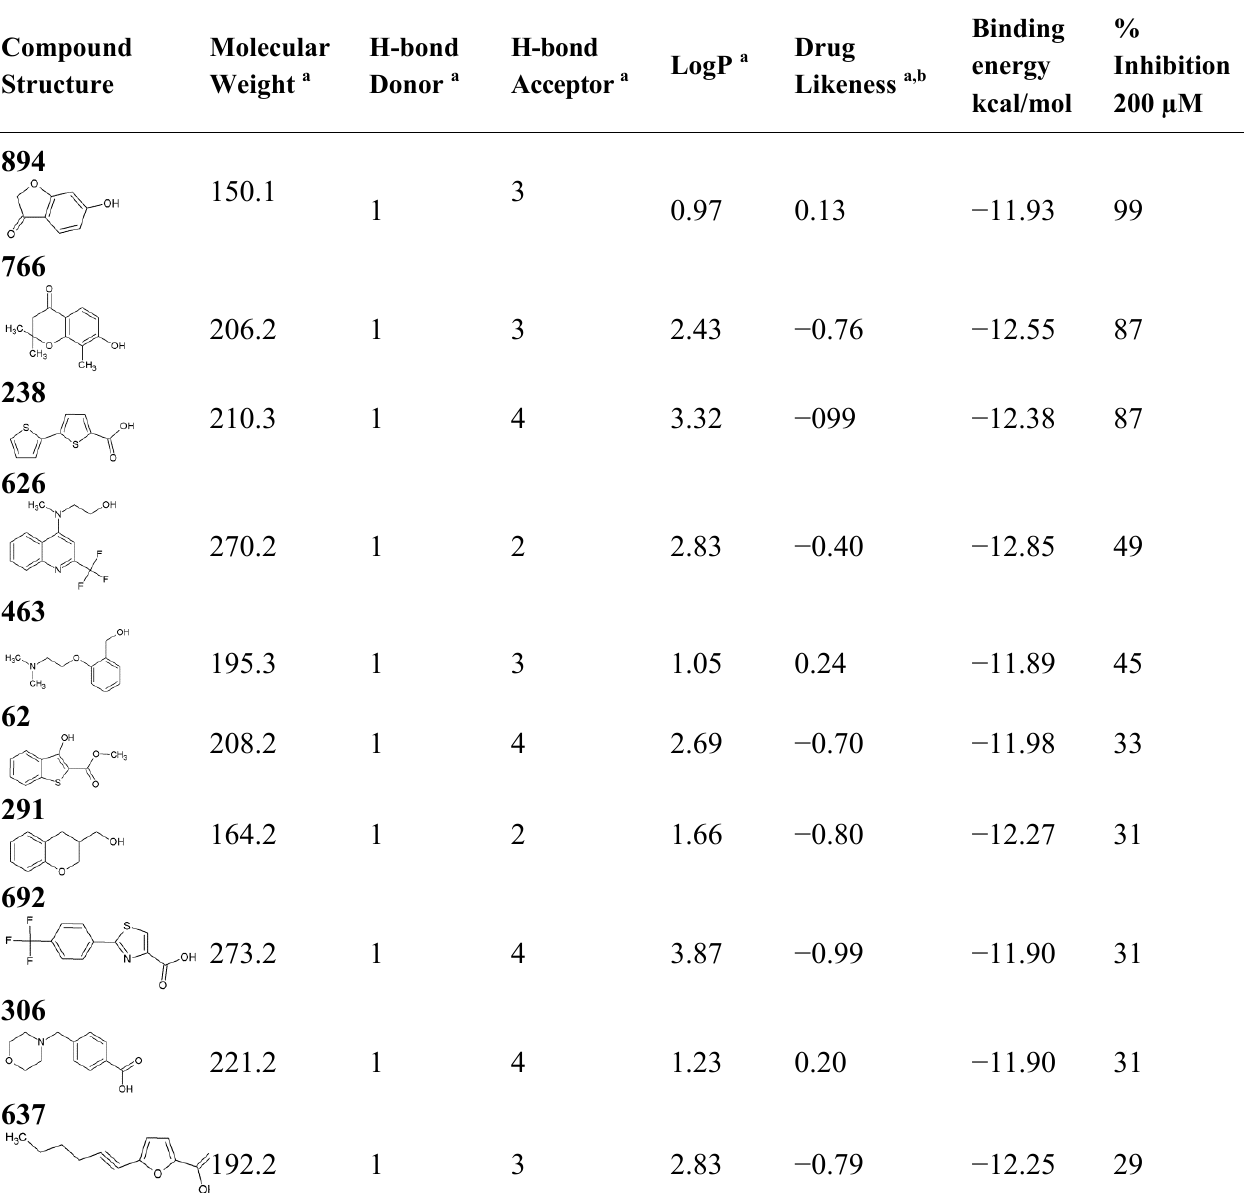
Table 2. Molecular properties and drug likeness of the ten most potent. SaSDH inhibitors found through virtual